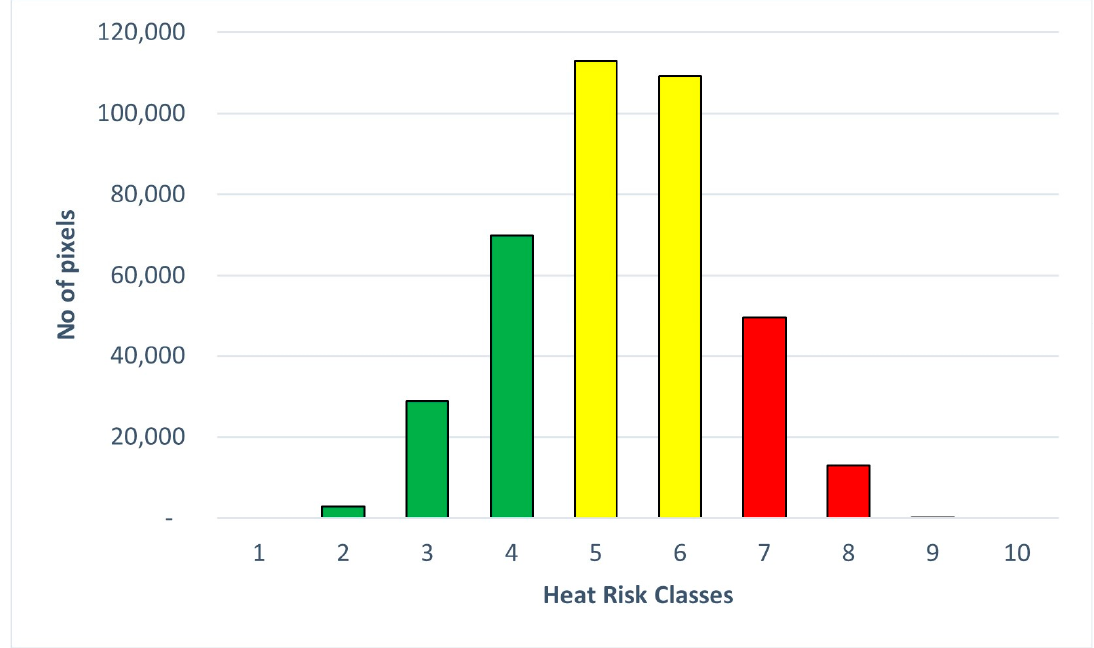
Figure 3. Distribution of heat risk classes.